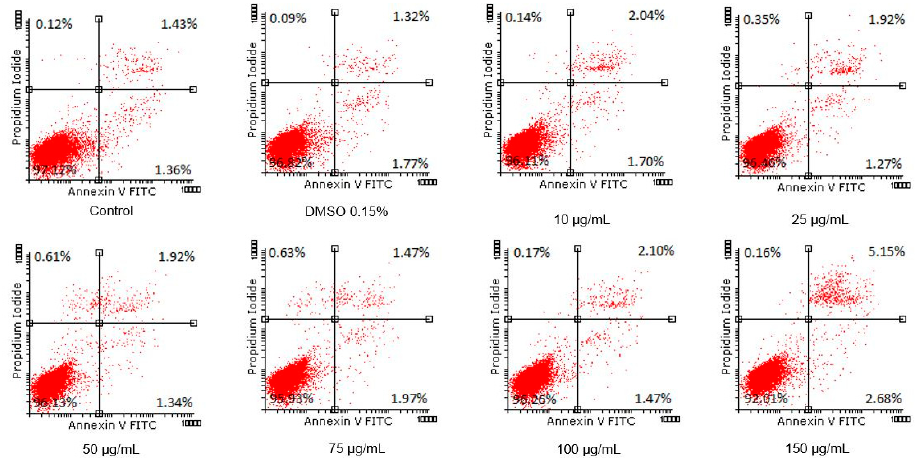
Figure 8. Representative dot-plots. Viability of A549 human lung adenocarcinoma cell line using Annexin V/PI analysis.